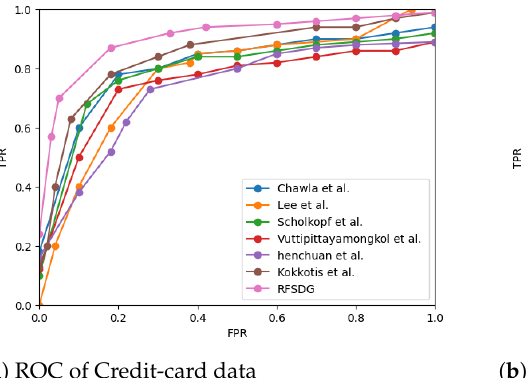
Figure 3. Comparison of ROC